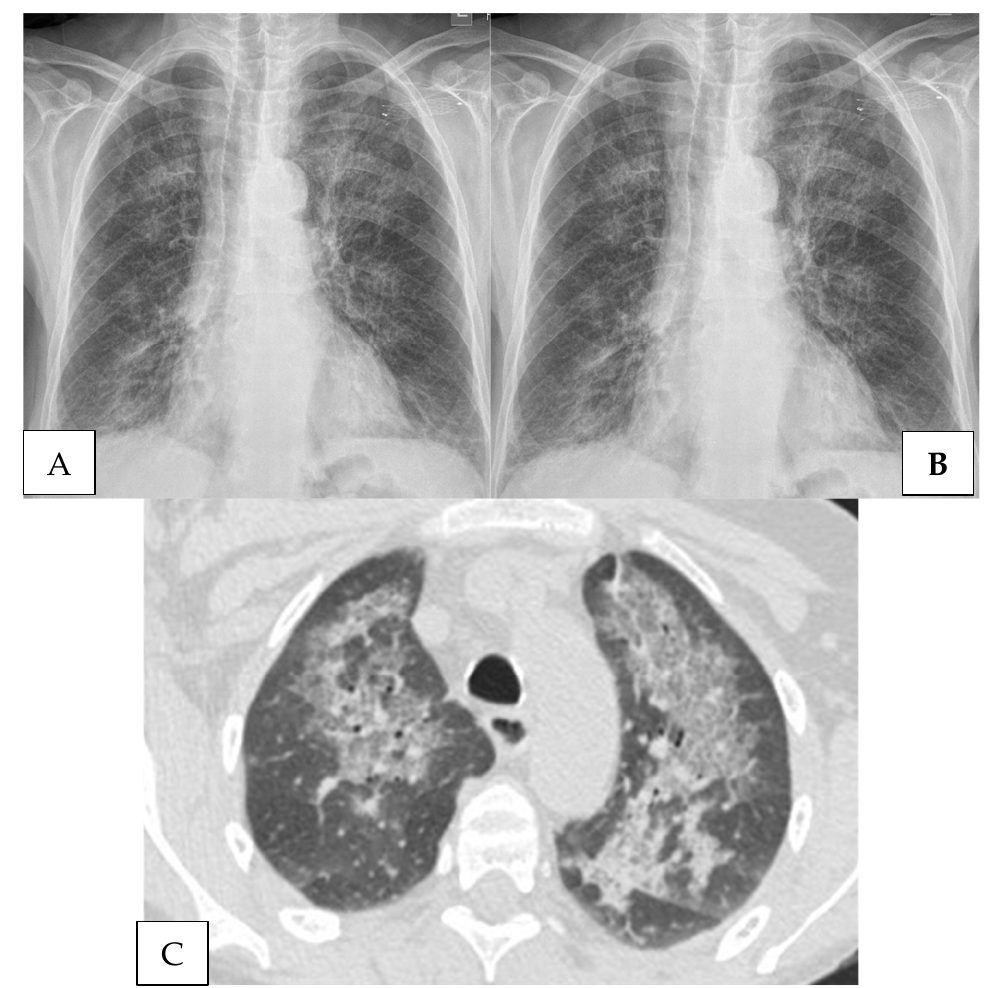
Figure 1. A 65-year-old woman 18 months after deceased donor kidney transplantation presents to emergency room with increasing dyspnea over the past three weeks and new fevers. She completed trimethoprim-sulfamethoxazole prophylaxis one year prior to admission. She is hypoxic with decreased breath sounds bilaterally and fine diffuse crackles, LDH is 416, β -1,3-glucan assay positive (>500), and induced sputum sample positive of Pneumocystis jiroveci by immunofluorescence. ( A ). Baseline chest radiograph. ( B ). Admission chest radiograph with slightly increased upper lobe ground glass markings. ( C ). Chest CT scan without intravenous contrast reveals a mixed pattern of patchy ground-glass opacities and scattered dense pulmonary infiltrates with associated septal